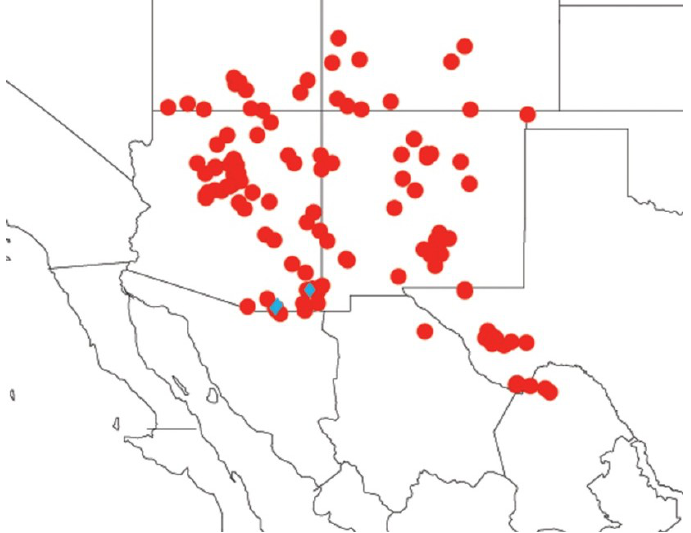
Figure 19. Distribution of Tibicen duryi (red circles) and T. longioperculus (blue diamonds).